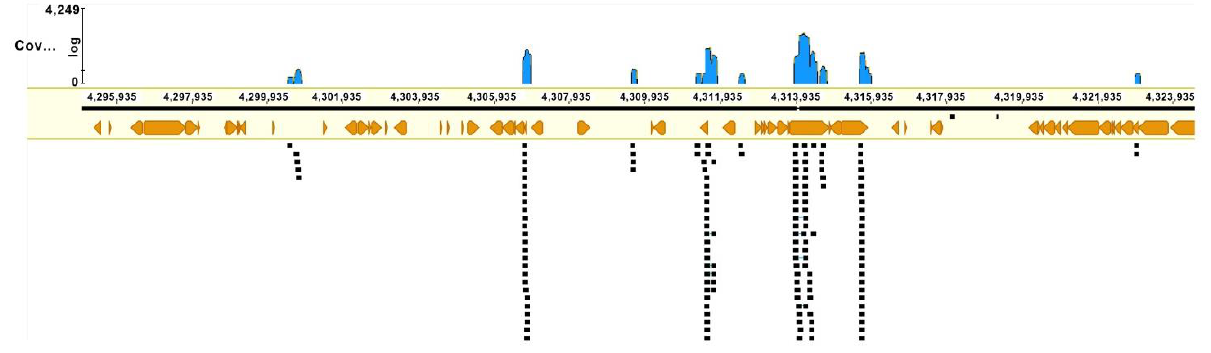
Figure 11. An example of mapping of reads in the region of the inversion. Black squares represent reads, and orange symbols denote repetitive DNA elements.